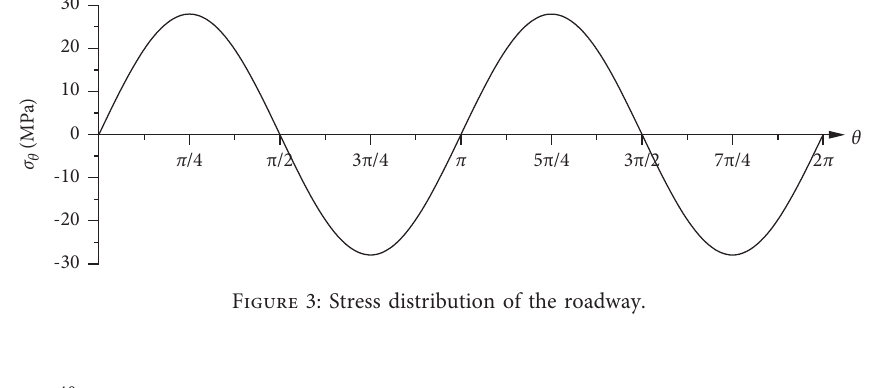
Figure 3: Stress distribution of the roadway.